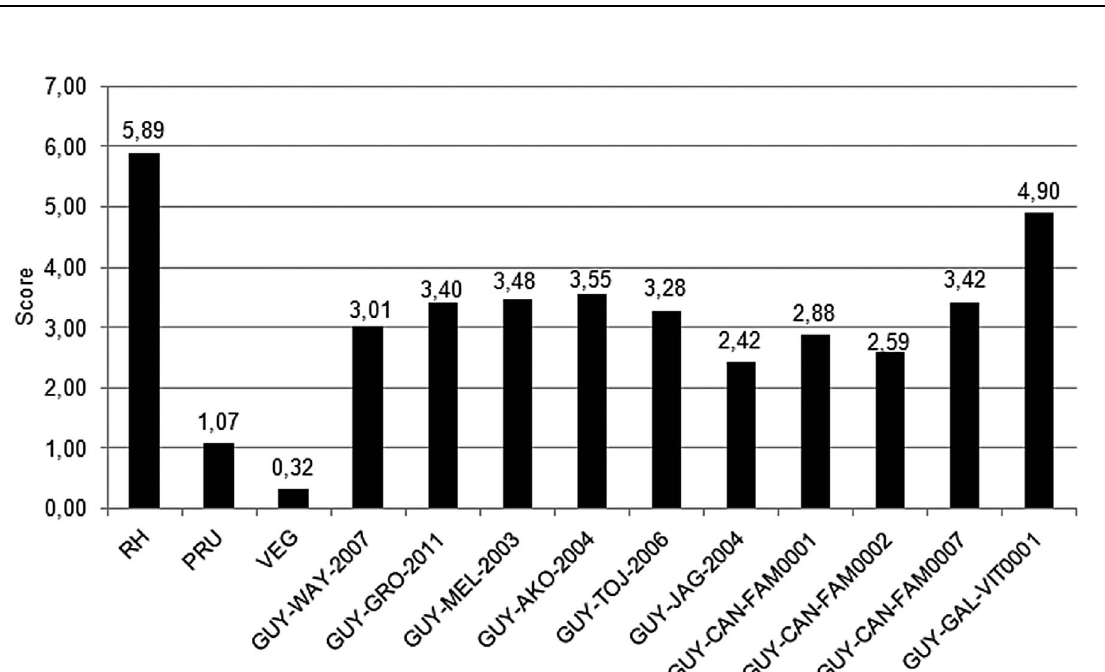
Figure 3. Scoring of virulence of Toxoplasma gondii strains isolated in French Guiana compared to reference strains type I, II and III. The fi rst three strains are the reference strains, the next fi ve strains are isolated from patients (with an increase in the severity of the symptoms), and the last fi ve strains are isolated from animals (three from domestic fauna and two from wildlife).